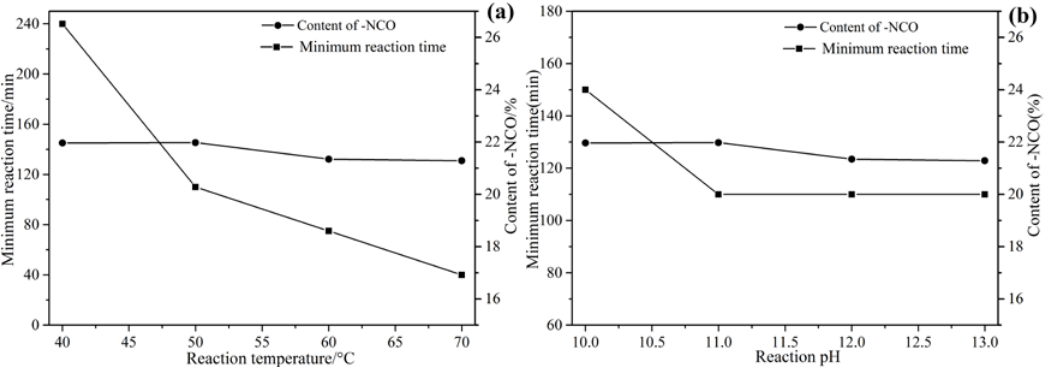
Figure 2. The minimum reaction time and –NCO content with different temperature ( a ) and pH ( b ).